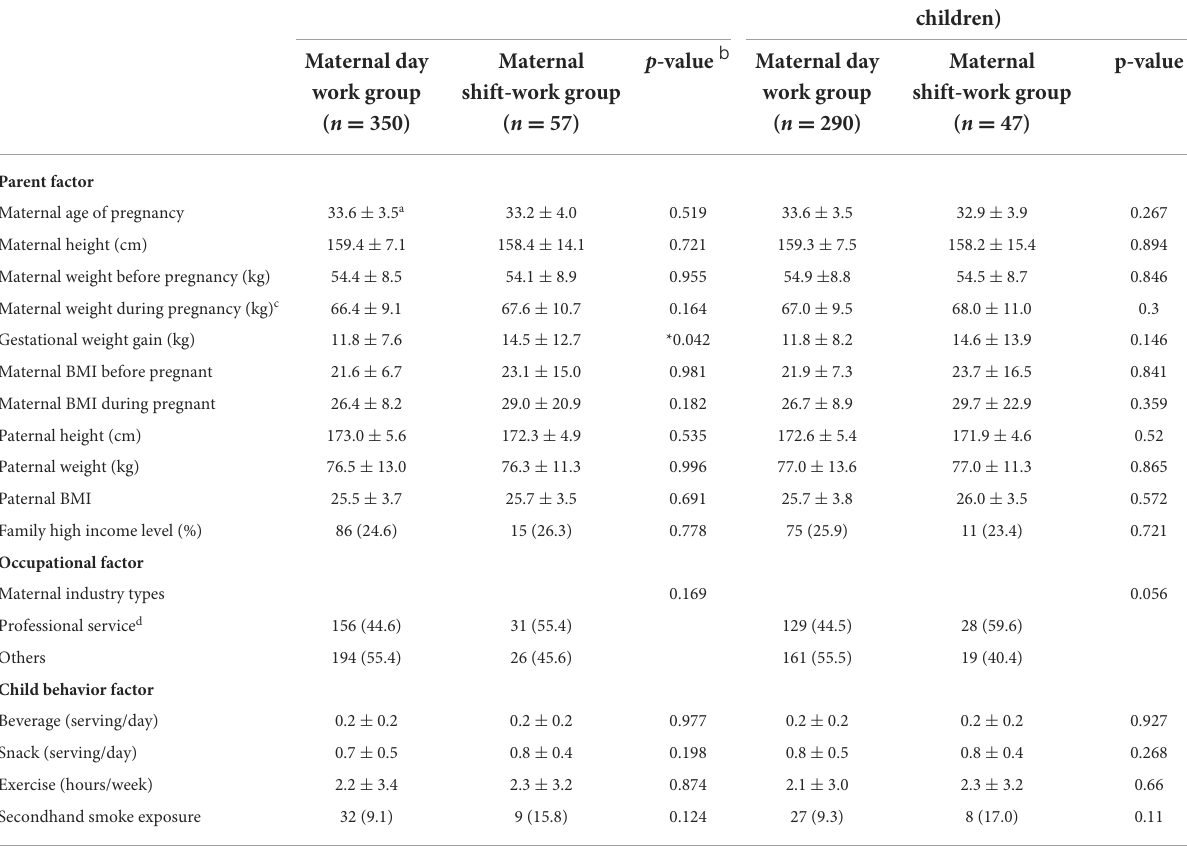
TABLE 1 Baseline characteristics of children and their parents.